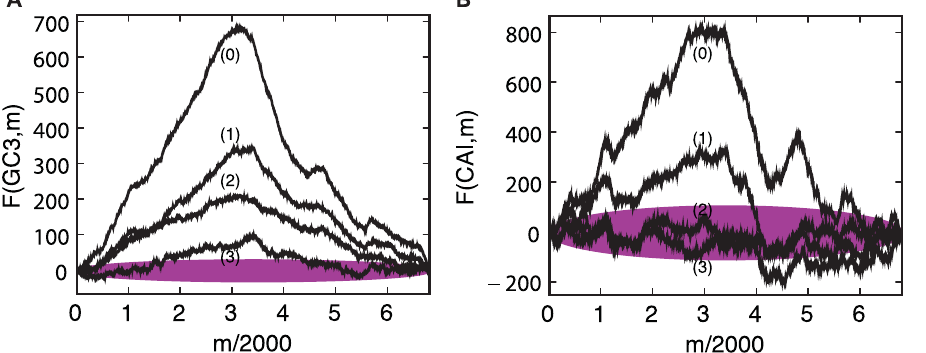
Figure 2. Snapshots of simulated synonymous mutation in the lambda phage genome. (A) Shows GC3 and (B) shows CAI landscapes. In between successive snapshots (labeled by integers), N synonymous mutations are introduced into the genome and the resulting landscape is shown, where N is the number of codons in the lambda phage genome (see the Genome Landscapes section). These snapshots show that the simulated genome landscapes approach the random null model, indicated by the purple band (see Figure 1). The final CAI landscape (3) lies almost completely within the purple band. Using the lambda phage mutation rate of 7.7 6 10 2 8 mutations/bp/replication [57], we can estimate that approximately 10 7 genome replications would be required to relax within the purple bars.